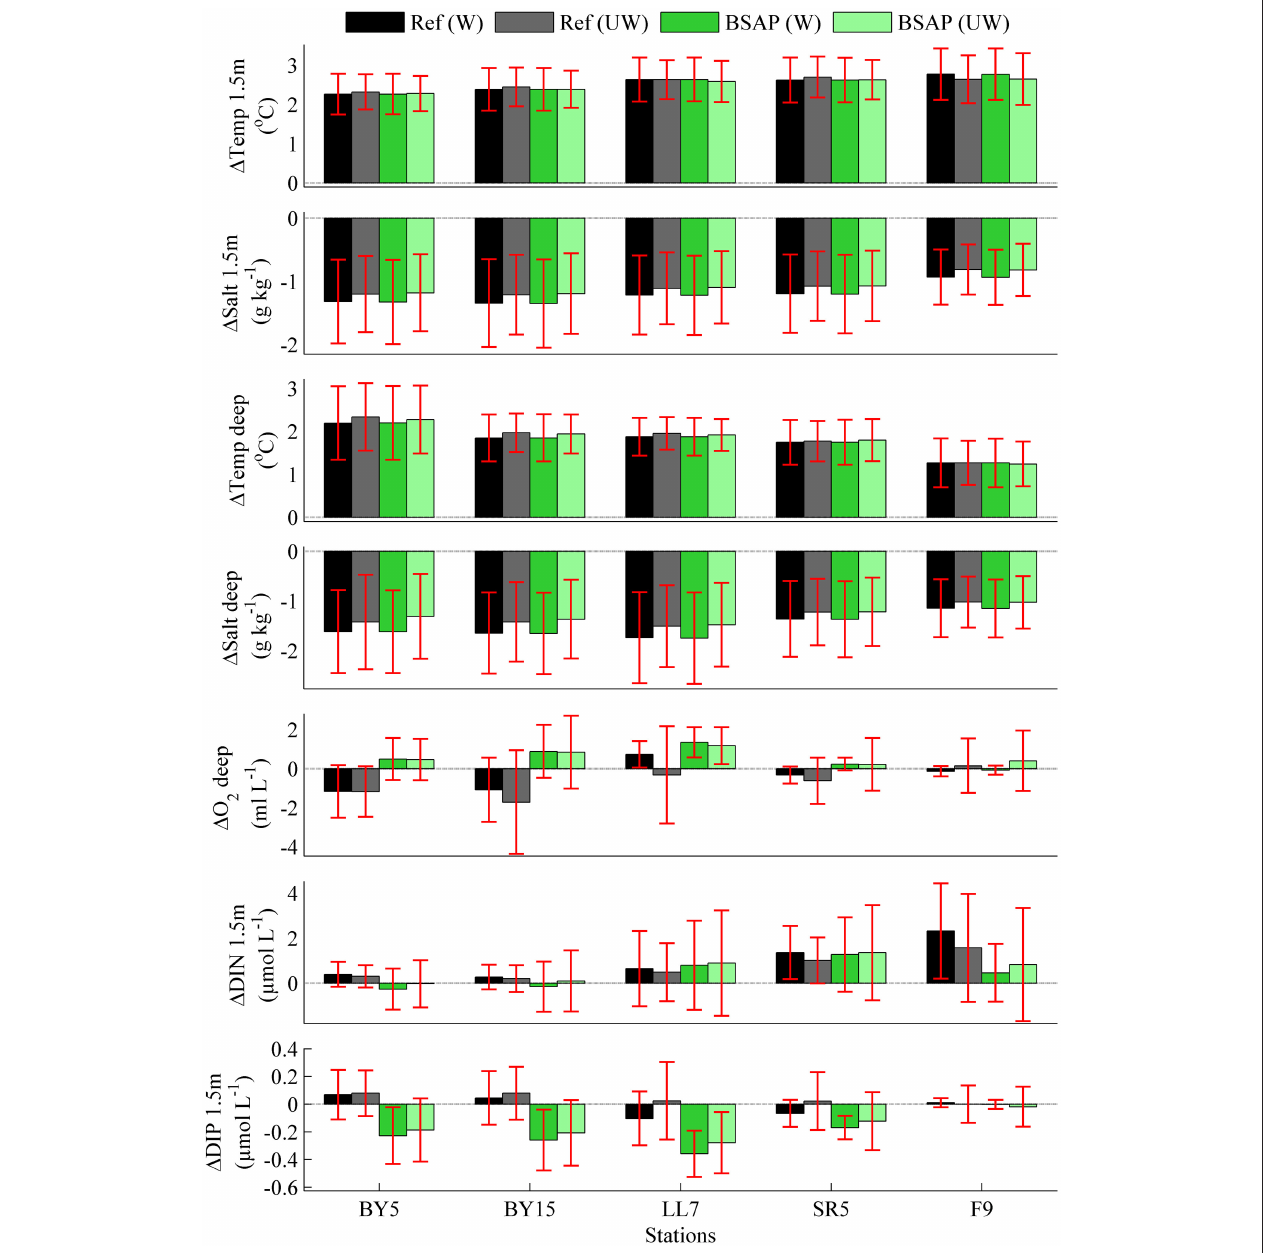
FIGURE 8 | Weighted and unweighted ensemble mean changes and standard deviations (represented by error bars) in REF and BSAP scenario simulations for temperature, salinity, oxygen, dissolved inorganic nitrogen and phosphorus concentrations at the monitoring stations BY5, BY15, LL07, SR5 and F9 at 1.5 and 200m depth. Data have been extracted from the models’ top grid cell for the surface layer (1.5 m) and for the grid cell closest to 200m or the deepest grid cell for the deep layer (deep). “W” and “UW” refer to weighted and unweighted ensemble mean